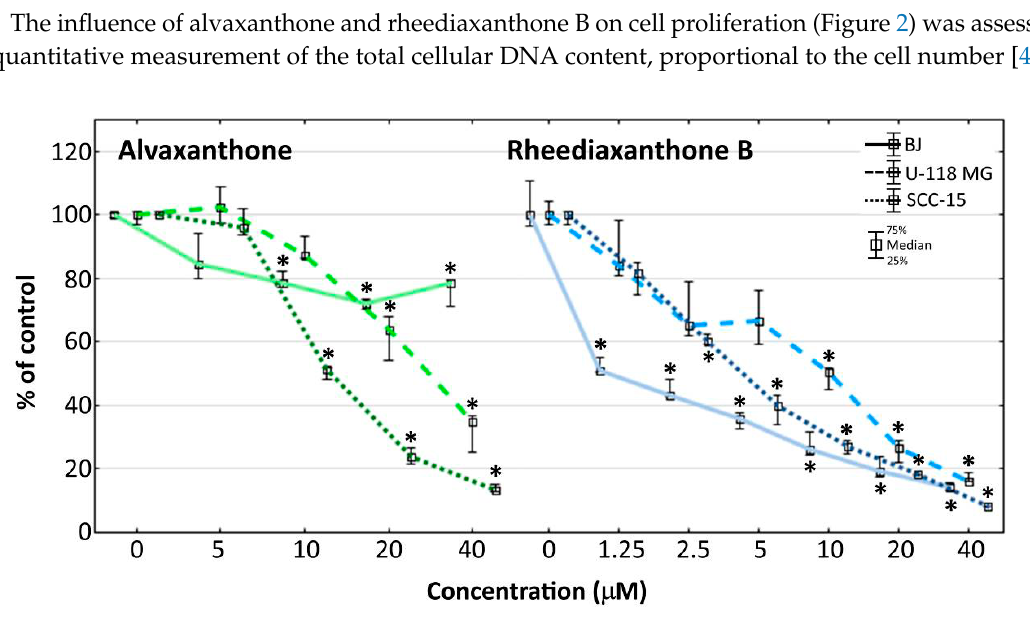
Figure 2. Proliferation of cancer (U-118 MG and SCC-15) and normal (BJ) cells after 72 h incubation with 5–40 µM alvaxanthone or 1.25–40 µM rheediaxanthone B, determined with the CyQUANT GR Cell Proliferation Assay Kit. Median results are presented of three independent experiments, each performed in triplicate. The whiskers are lower (25%) and upper (75%) quartile ranges. The results significantly different from control (in view of the Kruskal–Wallis test) are indicated *( p ≤ 0.05). Images collected with Olympus IX-83 microscope with contrast phase (scale bar = 100 µm).